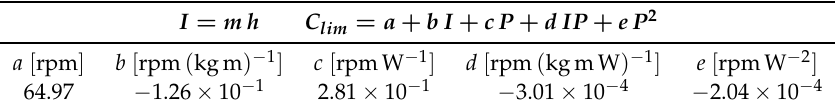
Figure 7. ( a ) Fitting by Equation (19) of data obtained by minimizing EMCF: C lim versus I for different power outputs; ( b ) Diagram of the optimal cadence C lim from Equation (19). Table 5. Best fit coefficients for Equation